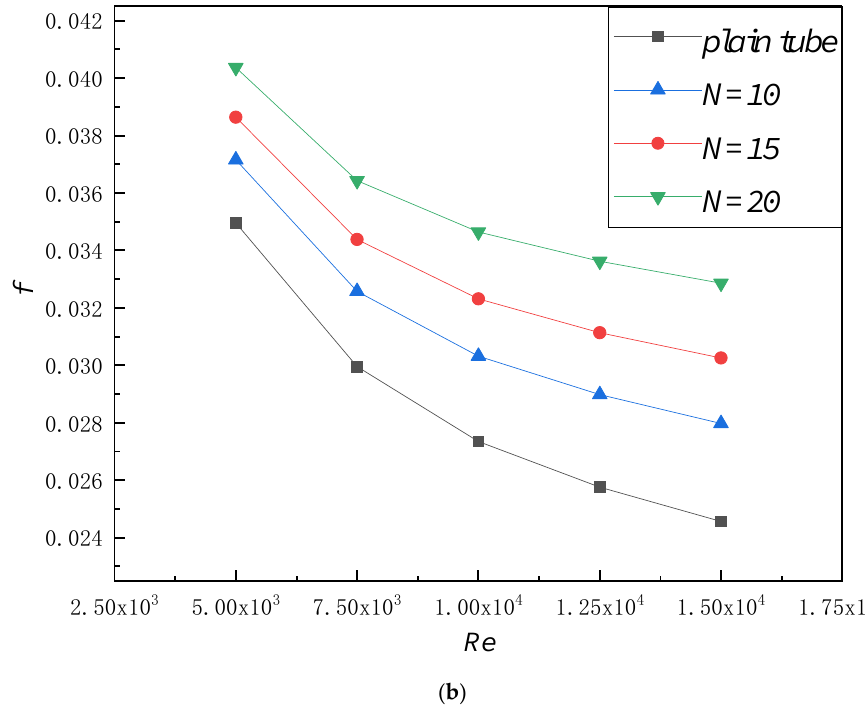
Figure 9. Comparison of heat transfer and flow resistance between plain tube and smooth tube with RWVGs in different N . ( a ) Nu , ( b ) f .